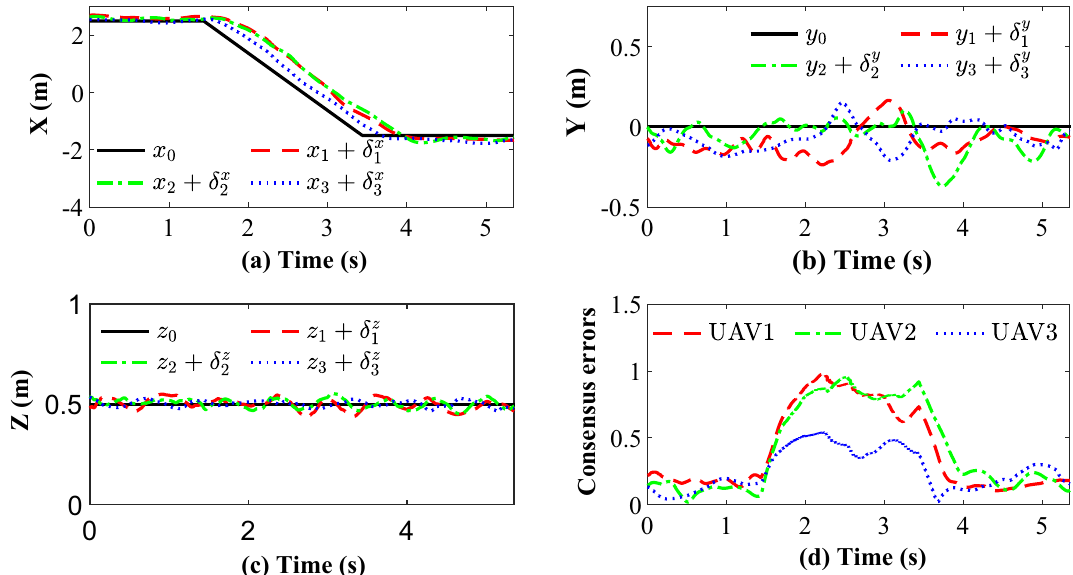
Figure 20. Experimental results based on algorithm 37 : ( a ), ( b ), ( c ) and ( d ) represent X, Y, Z position trajectory and consensus error (m),